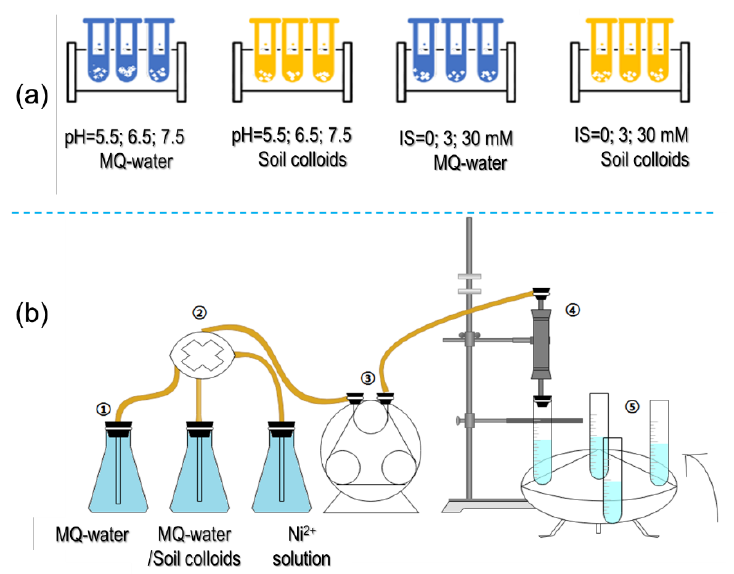
Figure 1. Schematic illustration of experimental setup ( a ) batch experiments ( b ) column experiments; experimental solutions; a three-way valve; peristaltic pump; a column containing the porous medium; fully automatic partial collector.